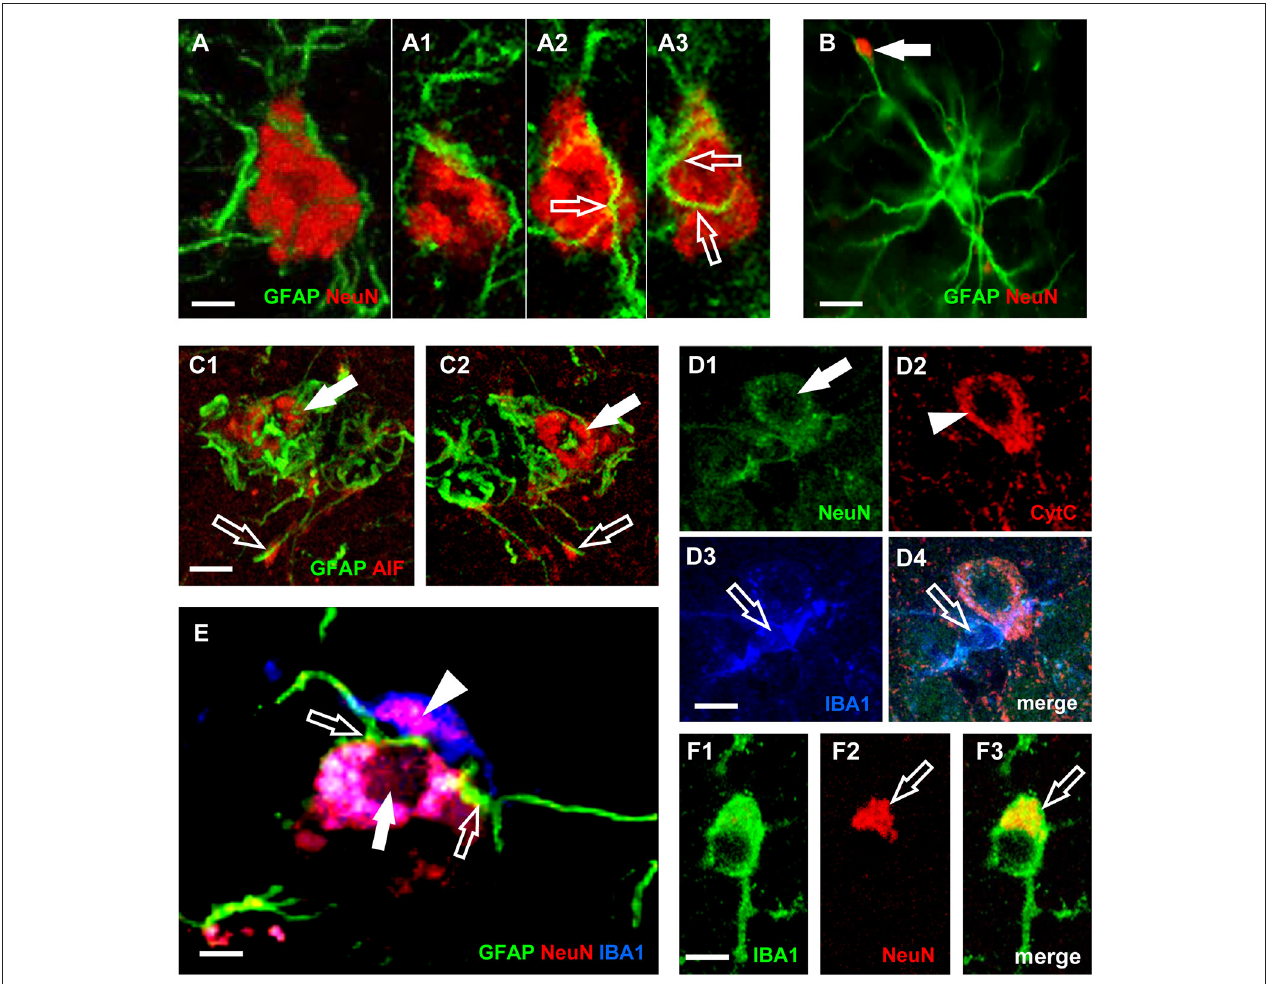
FIGURE 3 | Characterization of neurons-astrocytes-microglia interplay and apoptosis. (A) Confocal microscopy acquisition of GFAP (green) and NeuN immunostaining (red). Scale bar: 5 µ m (A1–A3) . Digital subslicing of the neuron in (A) . Images are the merge of two contiguous confocal acquisitions. Serial confocal images that digitally sub-slice the neuron cell body (A1–A3) clearly demonstrate that astrocyte branches are present inside and infiltrate the neuron body [open arrows in (A2,A3) ]. Scale bar: 5 µ m. (B) The arrow shows a neuronal debris closely apposed to an astrocyte branch. The presence in the neuron cytoplasm of AIF (C1,C2) or of diffuse CytC immunostaining (D2) , are clear signs of apoptosis ( Suen et al., 2008). Scale bar: 15 µ m. (C1,C2) Immunostaining for AIF (red) and GFAP (green). Scale bar: 5 µ m. (D1–D4) Confocal acquisitions of NeuN (green), CytC (red), and IBA1 (blue) immunostaining acquired in CA3 region of aged rats. Digital subslice, total thickness 0.3 µ m, and the merge of the three other images (D4) . Scale bar: 15 µ m. (E) Digital subslicing of a neuron-astrocyte-microglia triad, obtained stacking seven contiguous confocal acquisitions. Open arrows point to astrocytes branches intermingling the body of a neuron. It is possible to appreciate the presence of an engulfed neuronal fragment within the body of the microglial cell (arrowhead). Scale bar: 10 µ m. (F1–F3) Digital subslicing of the Str. Radiatum of an aged rat of a IBA1-positive microglia (green). It is possible to highlight the presence of a NeuN-positive neuronal fragment [red, (F2) ] inside the microglial cell body [yellow-orange, (F3) , open arrow]. Scale bar: 7 µ m [Modified from Cerbai et al. (2012), Lana et al.